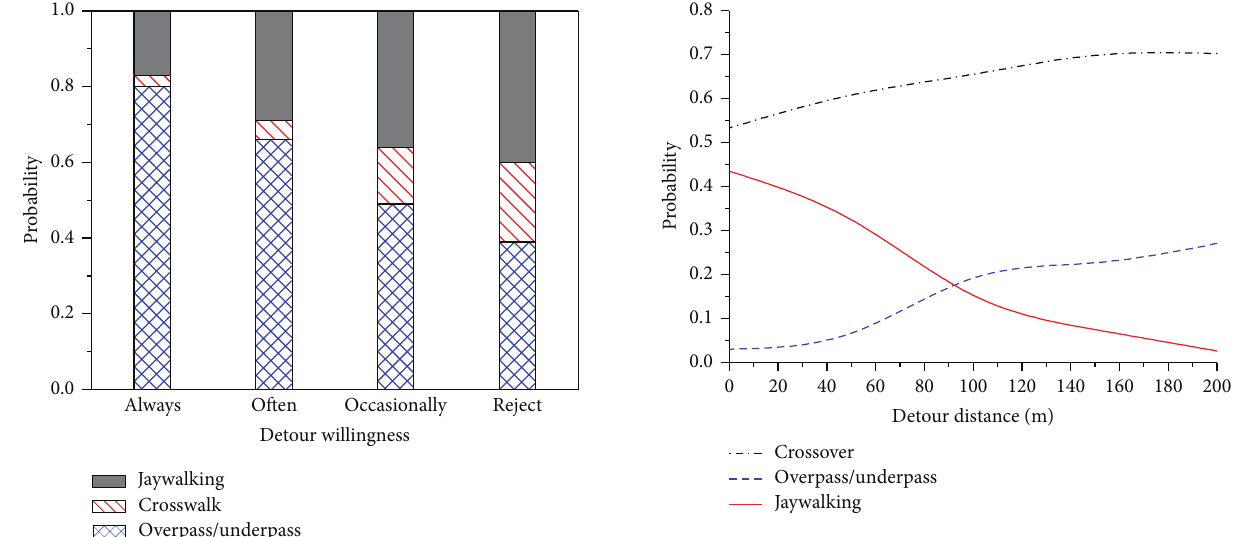
Figure 4: Probability of each alternative with different acceptable detour